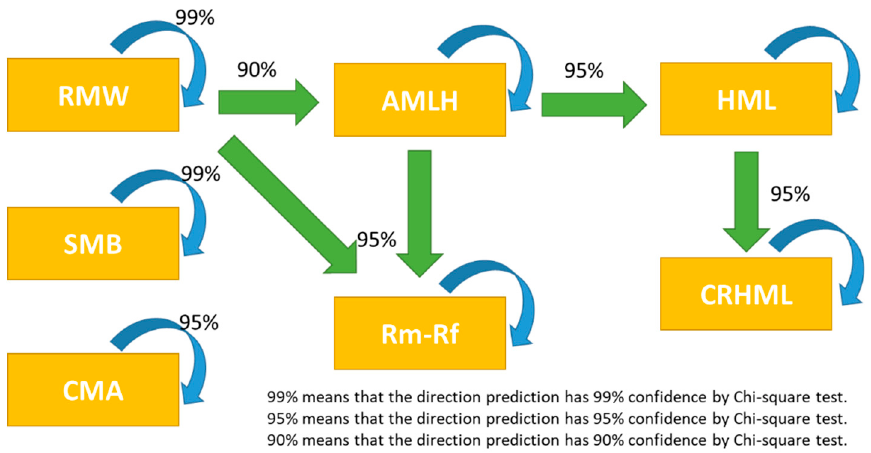
Figure 7. Summary of endogeneity and exogeneity for predicting direction of seven risk factors.